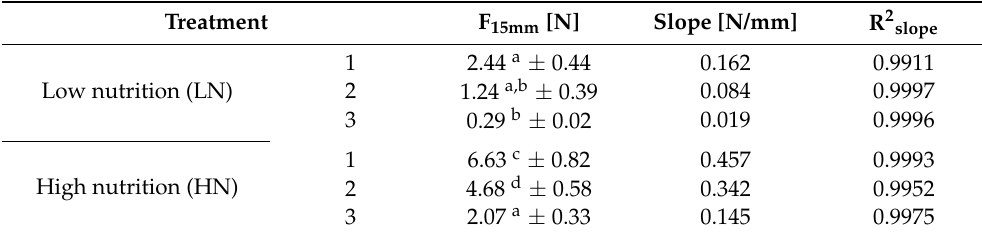
Table 2. The force needed for the penetration of the different substrates used in the first experiment for over 15 mm. The slopes of mean values of force over distance curves and the corresponding coefficients of determination (R 2 ) are shown. The presented values are the mean of three measure- ments (technical replicates) ± the standard deviations. Different letters indicate significant differences between samples.